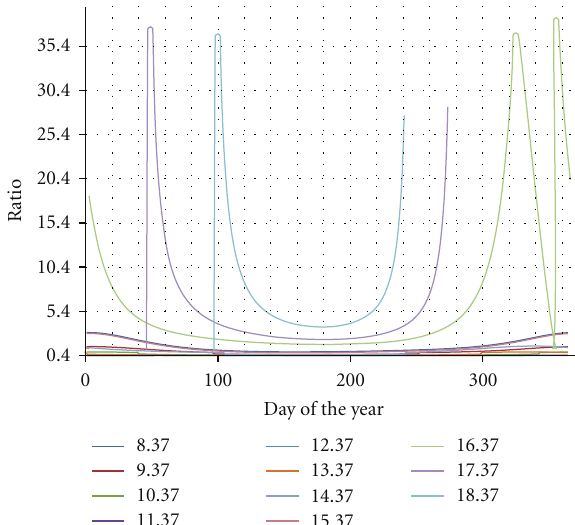
Figure 20: Ratio of mirror 4 along the year (shadows are consid-